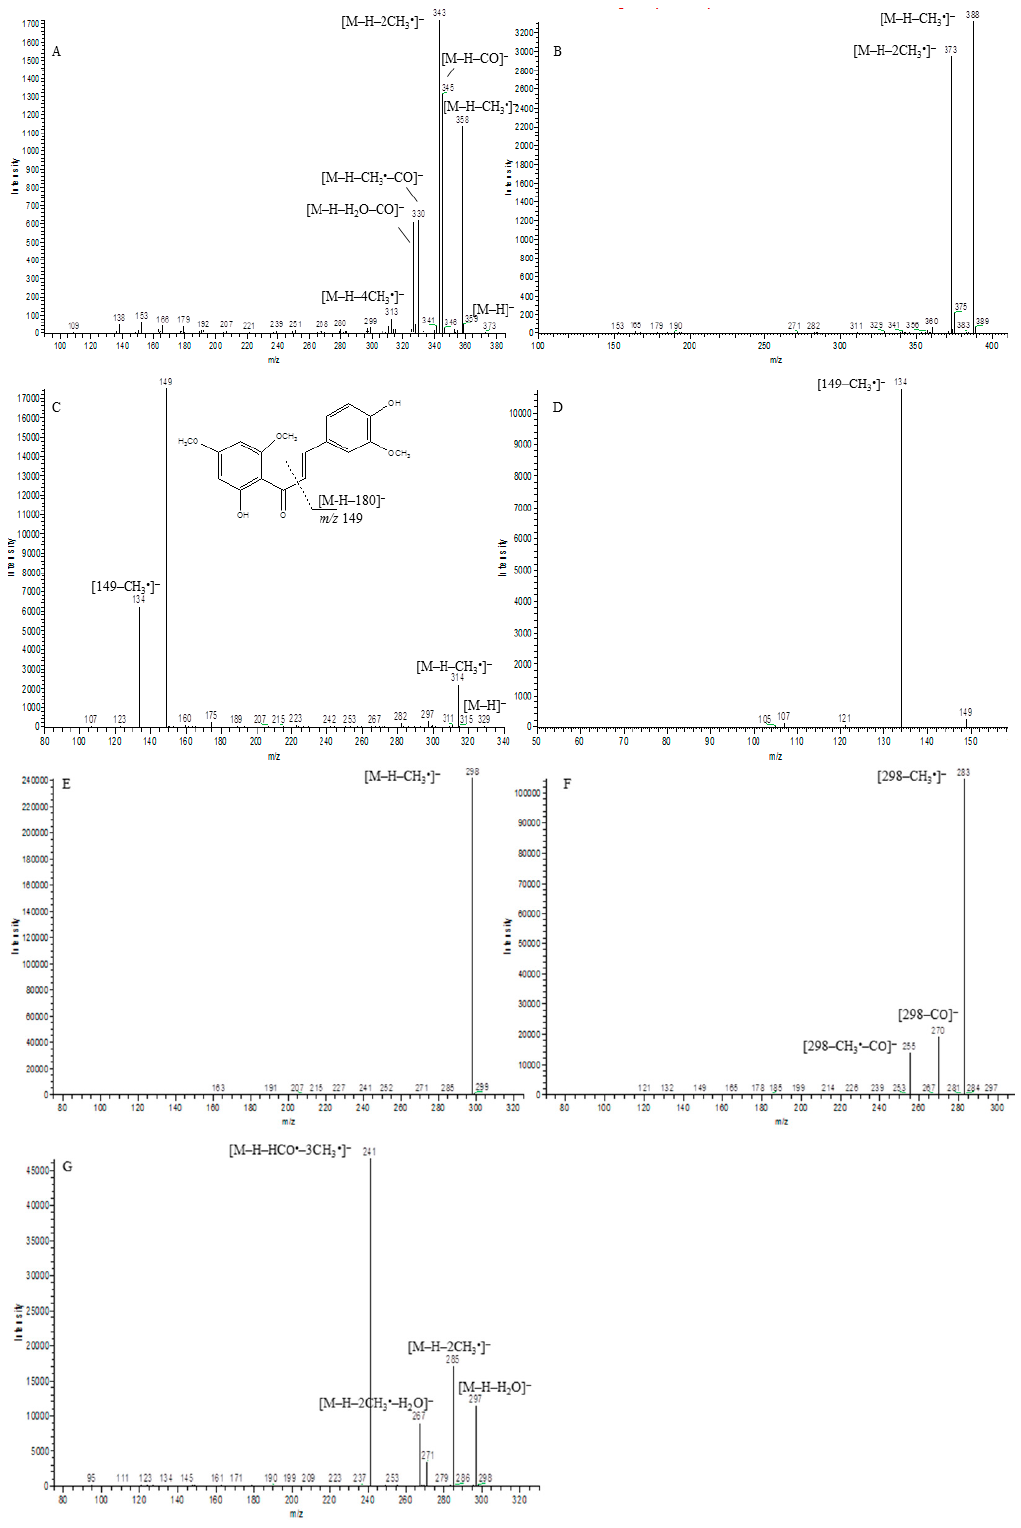
Figure 2. ESI-MS n spectra of four reference standards and M16 : ( A ) MS 2 spectrum of PTC; ( B ) MS 2 spectrum of 6 ′ -hydroxy-3,4,5,2 ′ ,3 ′ ,4 ′ -hexamethoxychalcone; ( C ) MS 2 spectrum of 4,6 ′ -dihydroxy-3,2 ′ ,4 ′ - trimythoxychalcone; ( D ) MS 3 spectrum of 4,6 ′ -dihydroxy-3,2 ′ ,4 ′ -trimethoxychalcone (precursor-ion was m/z 149); ( E ) MS 2 spectrum of velutin; ( F ) MS 3 spectrum of velutin (precursor-ion was m/z 298); ( G ) MS 2 spectrum of M16 .